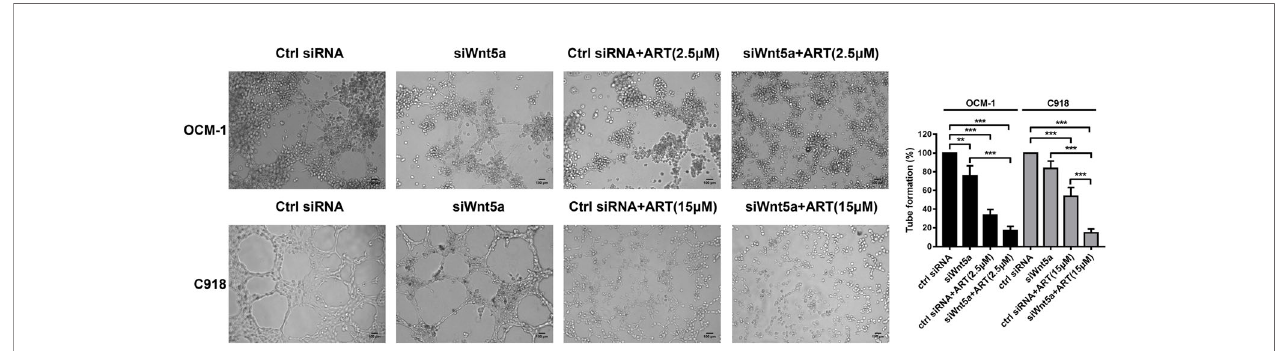
FIGURE 7 | ART interrupted VM formation in CM cells via Wnt5a/CaMKII pathway. OCM-1 and C918 cells transfected with Wnt5a siRNA or scrambled siRNA subsequently seeded on three-dimensional Matrigel layer culture for 24 h. OCM-1 and C918 cells transfected with Wnt5a siRNA showed a decrease in the number of tubes formed compared with cells transfected with scramble siRNA. Compared with the cells transfected only with small interfering RNA, transfected cells treated with ART have an enhanced inhibitory effect on tube formation. The results are represented as the mean ± SEM of three independent samples. **P < 0.01, ***P <